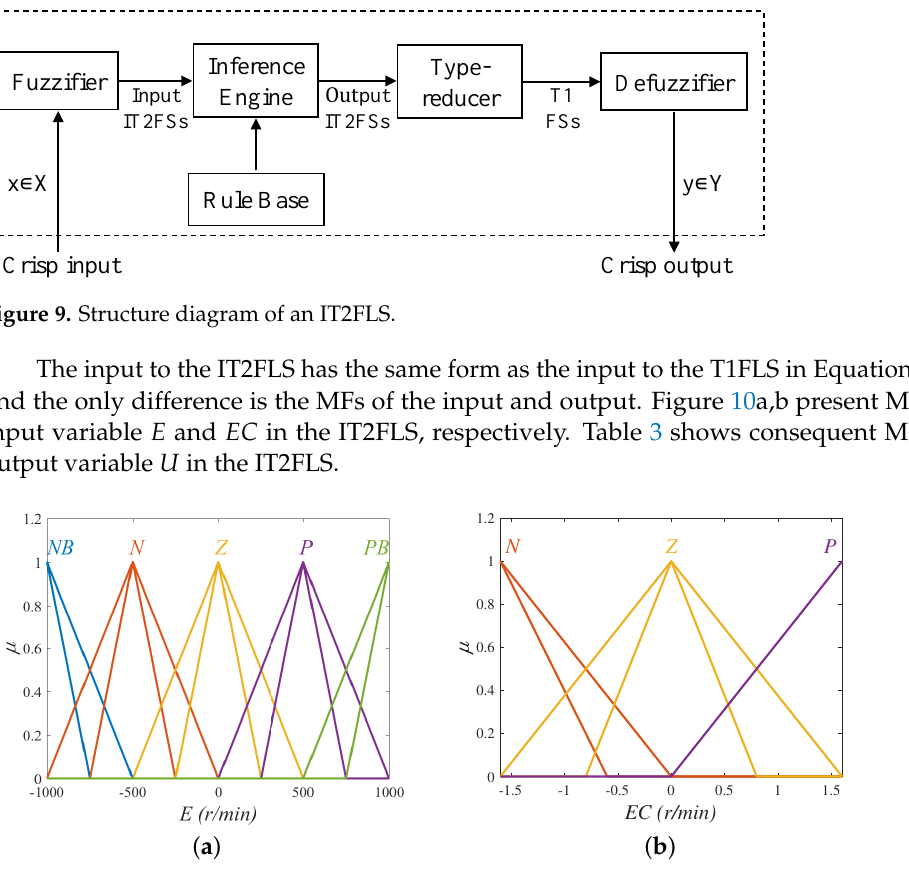
Figure 10. MFs of input variables in the IT2FLS. ( a ) MFs of input variable E ; ( b ) MFs of input variable EC . Table 3. The consequent MFs of output variable U in the